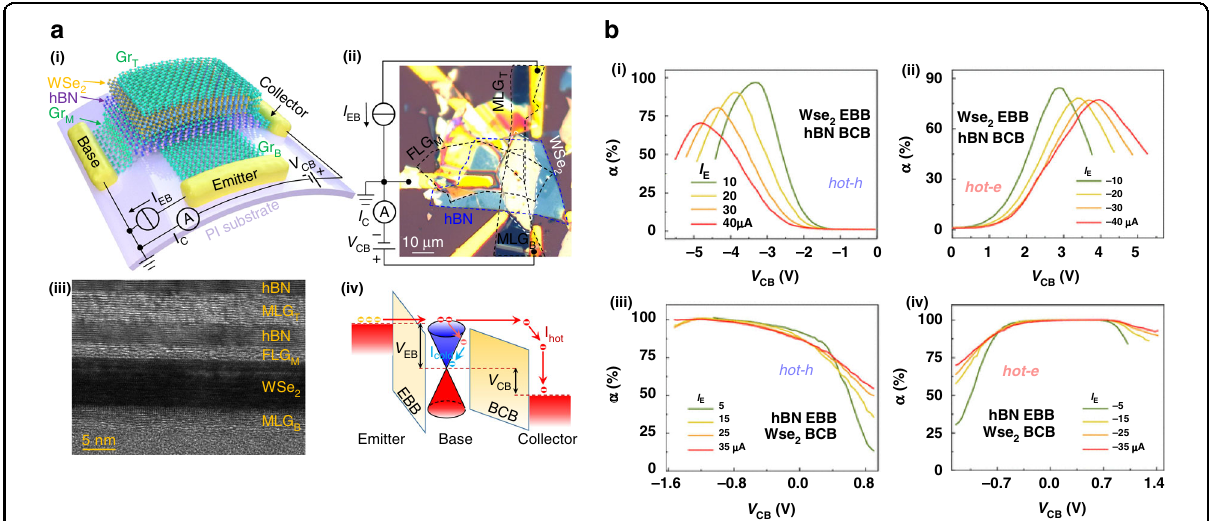
Fig. 20 The device architecture of a 2D Van der Wall hot-electron transistor and the related graphs for the HC collection ef fi ciencies. a The HET device design on a fl exible substrate showing the electrical connections, along with the optical image, TEM image of the real device and the energy band diagram representing the HC energetics and b the collection ef fi ciencies of HC under various bias conditions. The fi gures are taken with permission from ref.